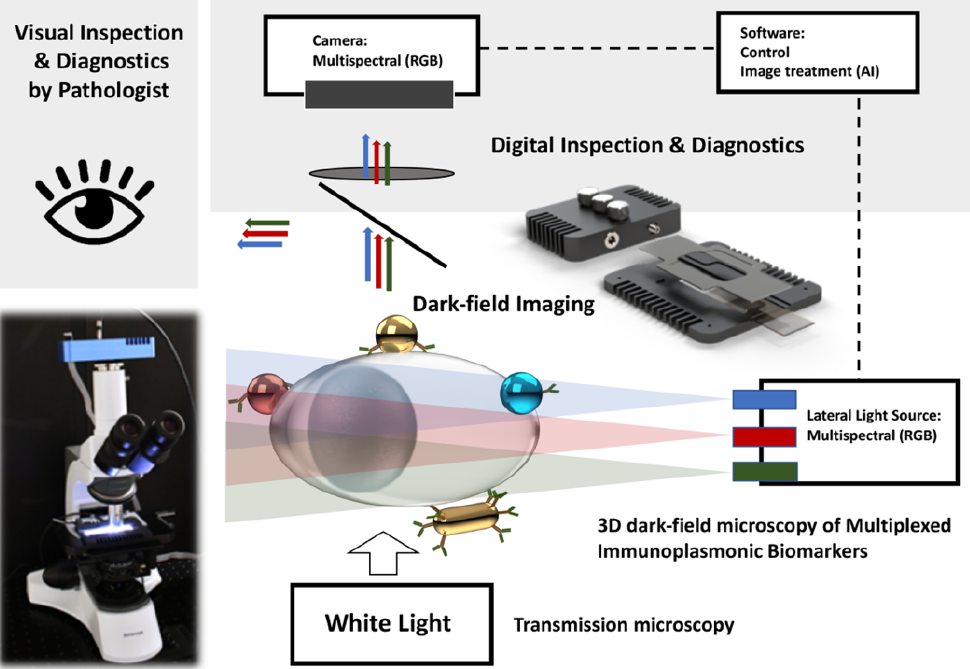
Figure 1. A schematic representation of a multimode microscopy setup integrated with VegaPhoton SI adaptor facilitating the visualization of red, green, blue, and yellow color scattering plasmonic NPs on H&E-stained cytology samples. As illustrated, different plasmonic NPs with their unique resonance peak on single cell are clearly visible in this setup. The multimode microscopy setup is composed of a (I) transmission microscopy (white light source) and (II) 3D dark-field microscopy (SI observation of plasmonic NPs) and can independently visualize each mode by simply switching from one mode to another.